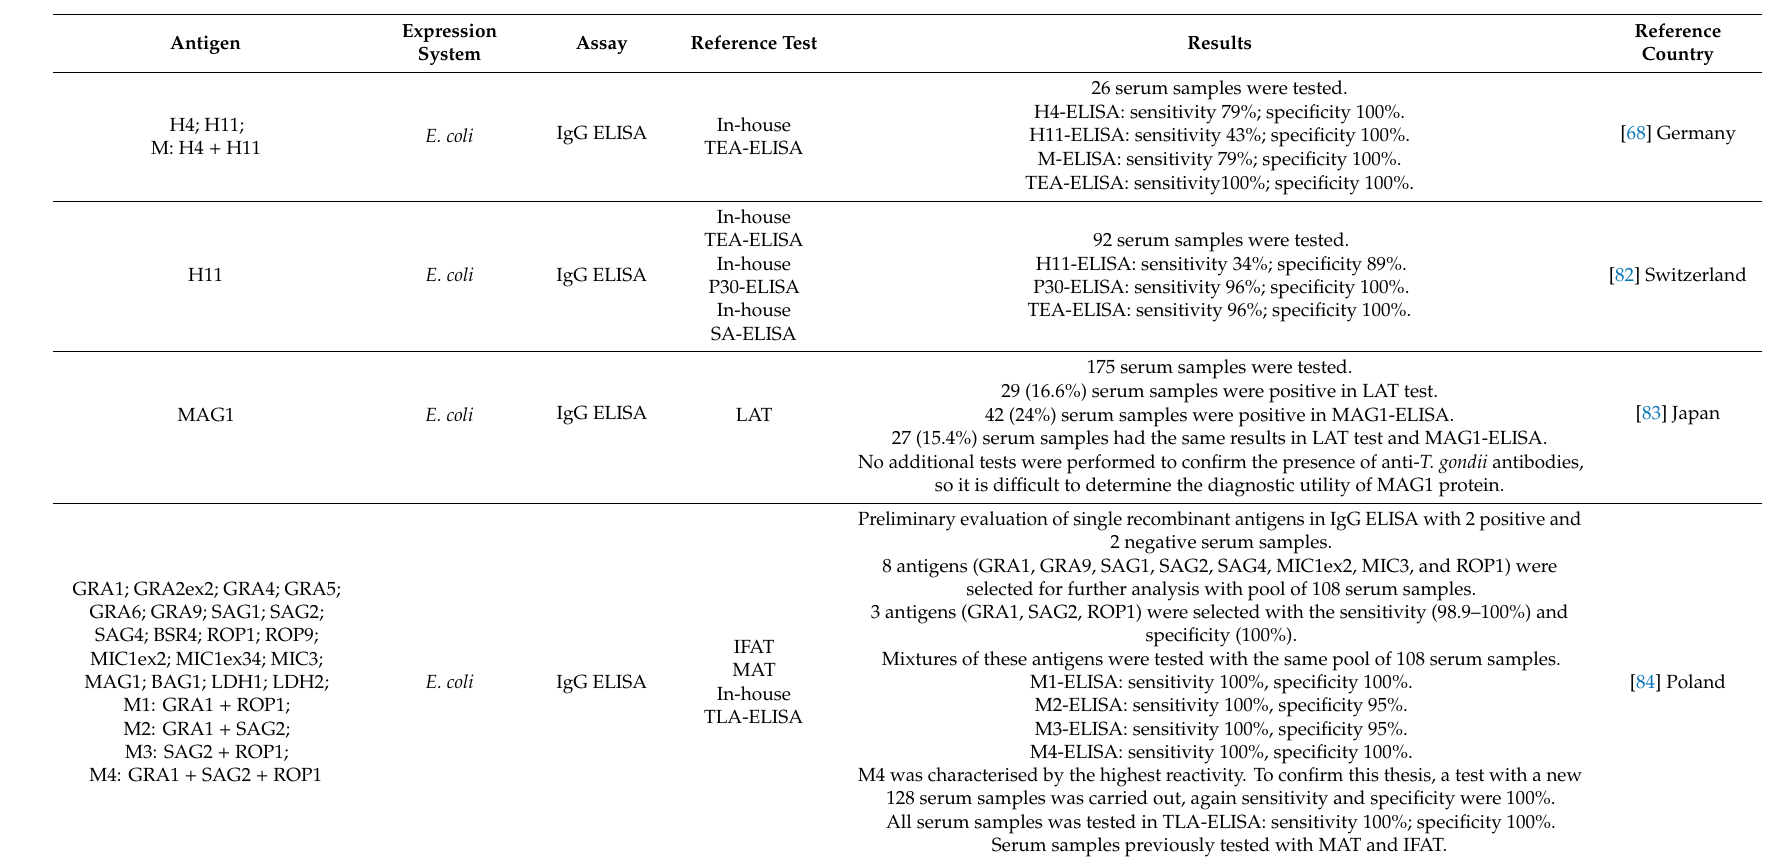
Table 4. Recombinant antigens used in detection of anti -T. gondii antibodies in ovine serum